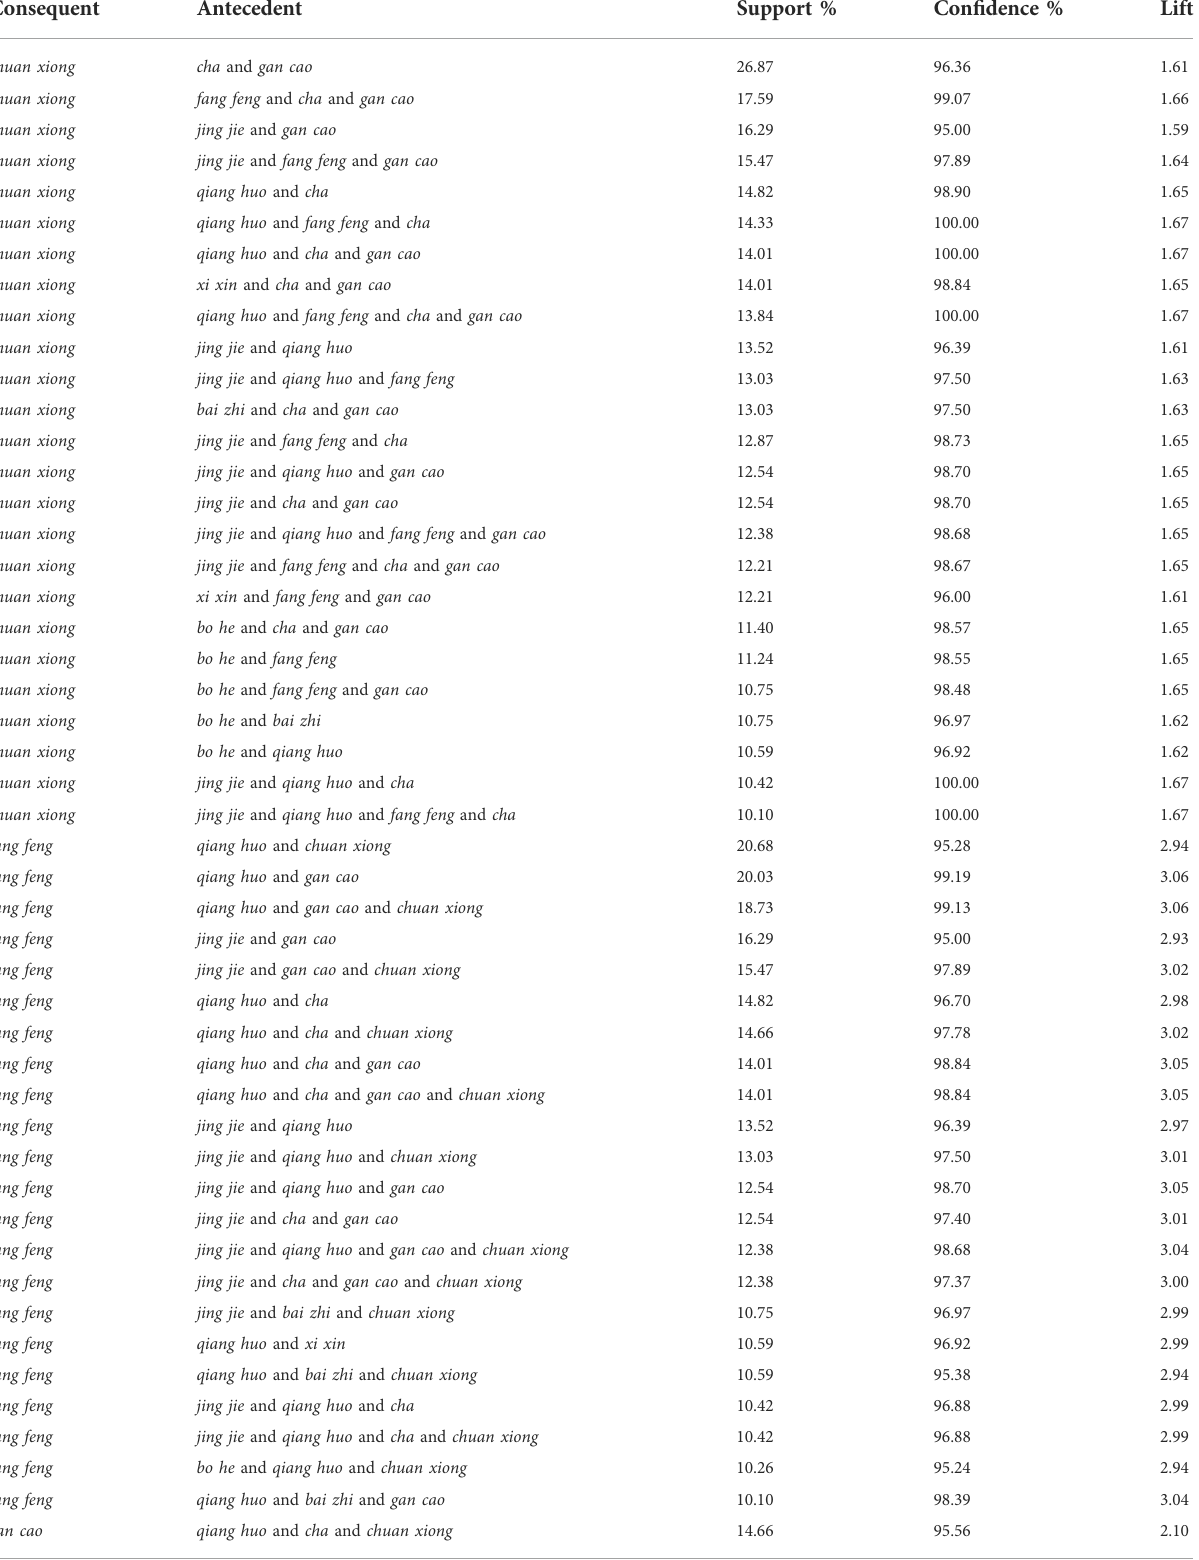
TABLE 3 Core herb combinations among the most-likely migraine citations.